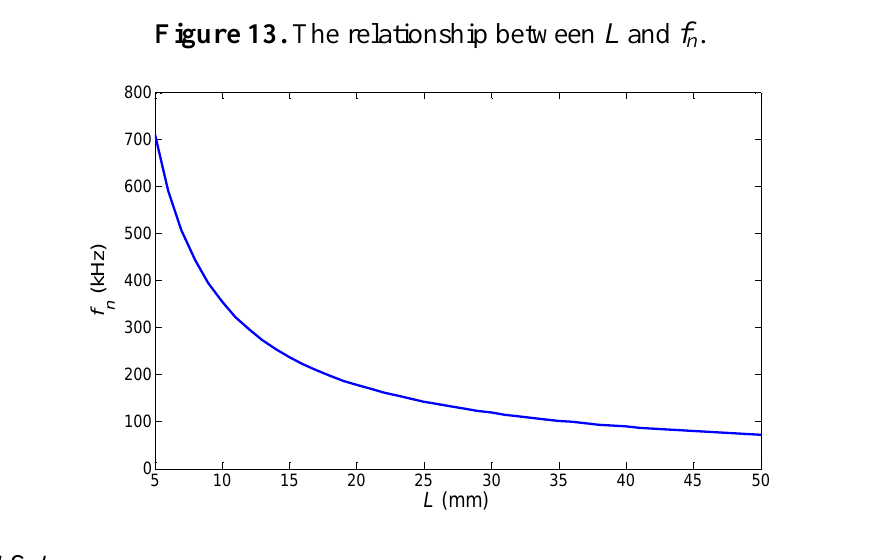
Figure 13. The relationship between L and f